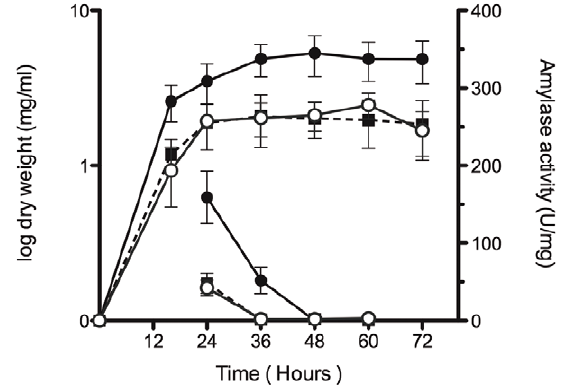
Figure 3. Alpha-amylase activity. Time-course of the S. lividans TK21 (pAMI11) (black circles), S.lividans D cssR (pAMI11) (white circles) and S. lividans D cssS (pAMI11) (black squares) bacterial cell cultures growing in NMMP medium (left Y axis). Alpha-amylase activity present in the culture supernatants was determined at the indicated times and is expressed as units per mg of protein (right Y axis). The data are the average of at least three independent determinations. Bars show standard